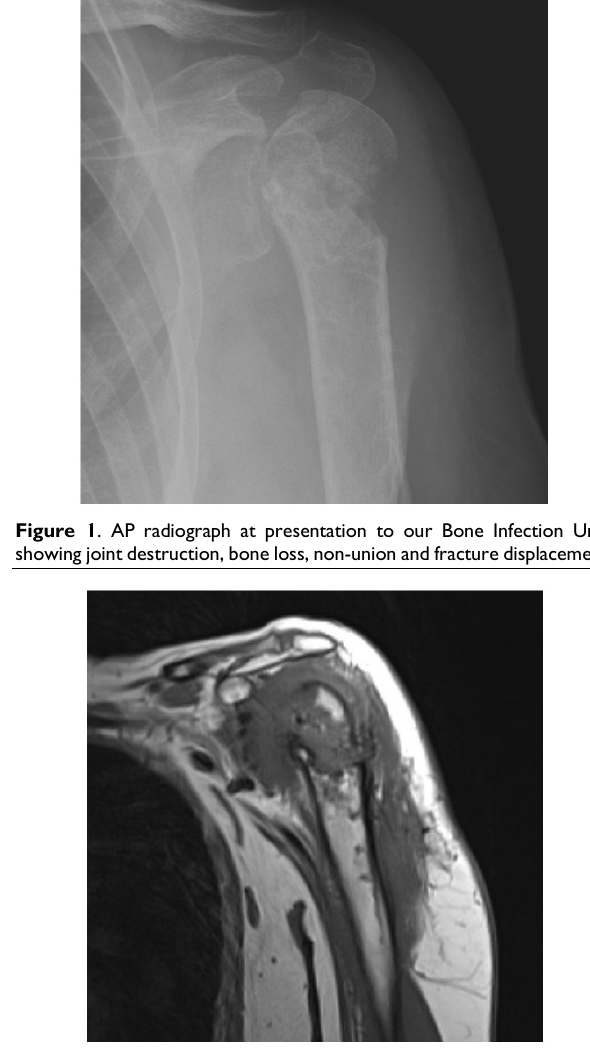
Figure 2 . MRI showing the non-union, the inflammatory mass in the joint with bone involvement in the humerus and